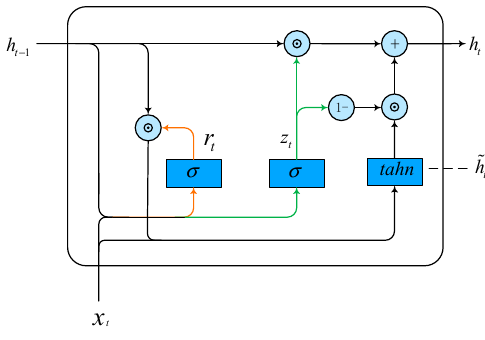
Figure 4. The structure of the GRU model.